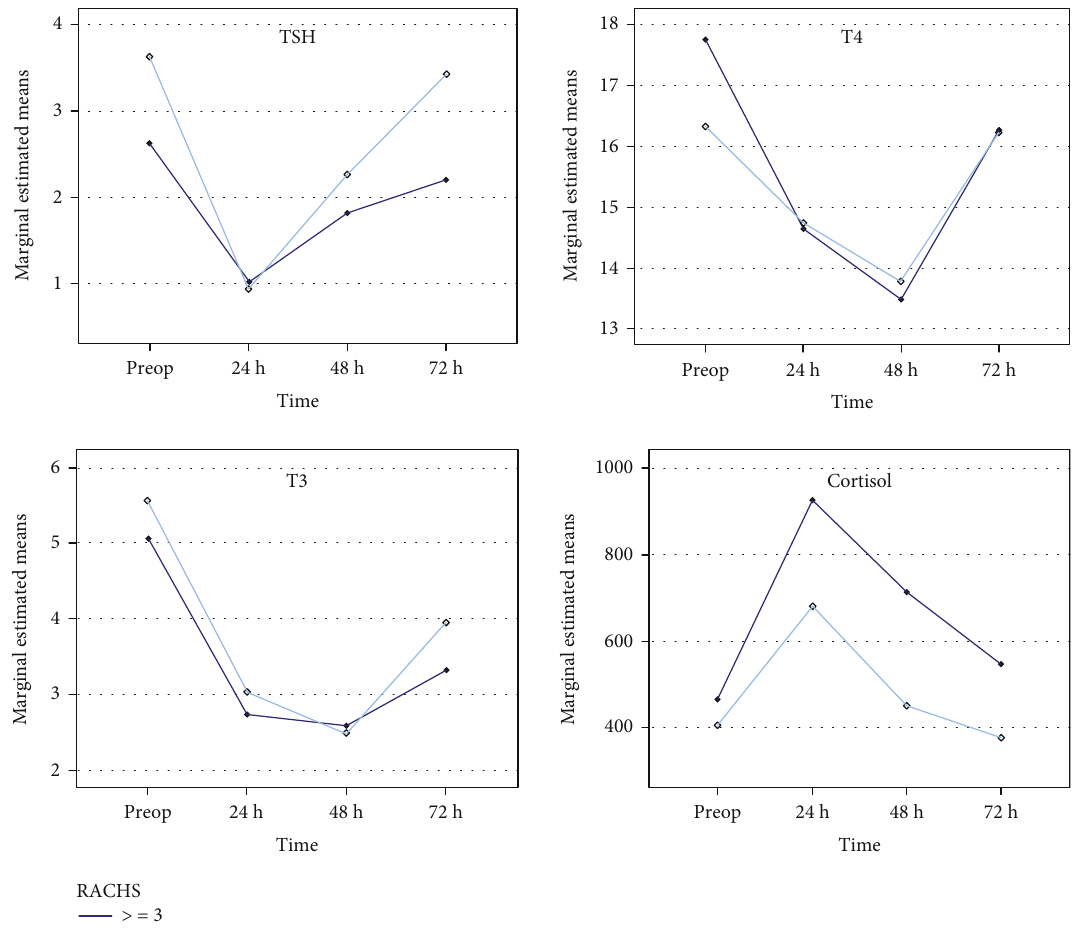
Figure 3: Changes in the thyroid function and cortisol levels over the early postoperative period (0-72 hours postop) following cardiac surgery with cardiac risk category score assessment (RACHS